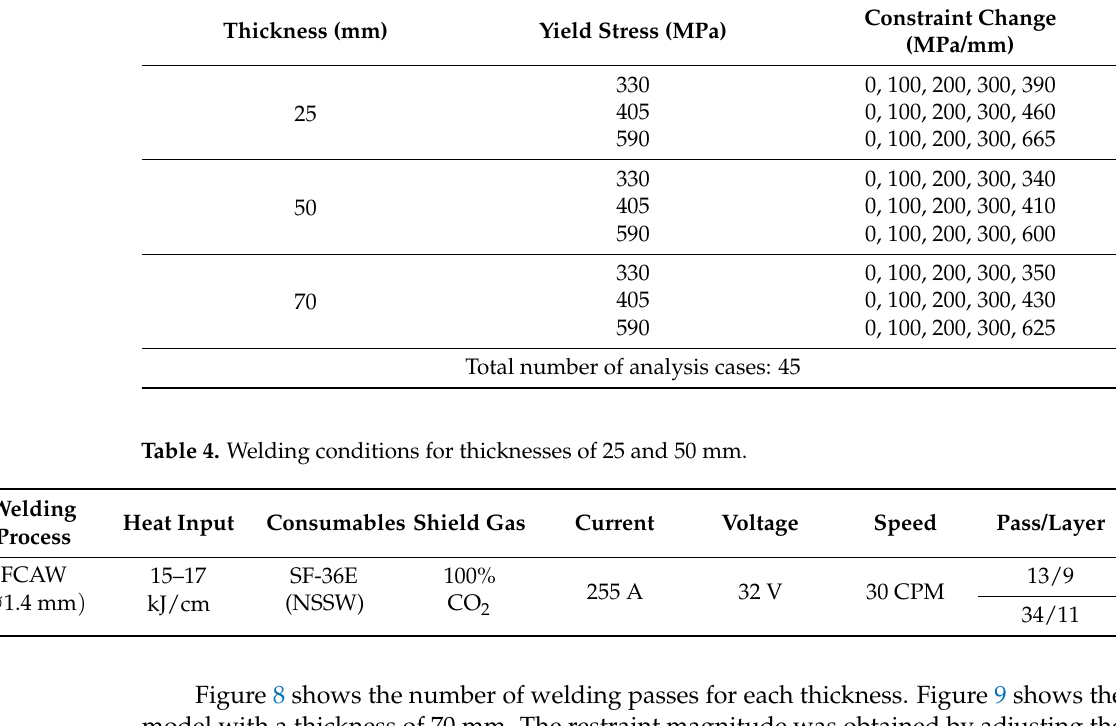
Table 3. Constraint analysis conditions.